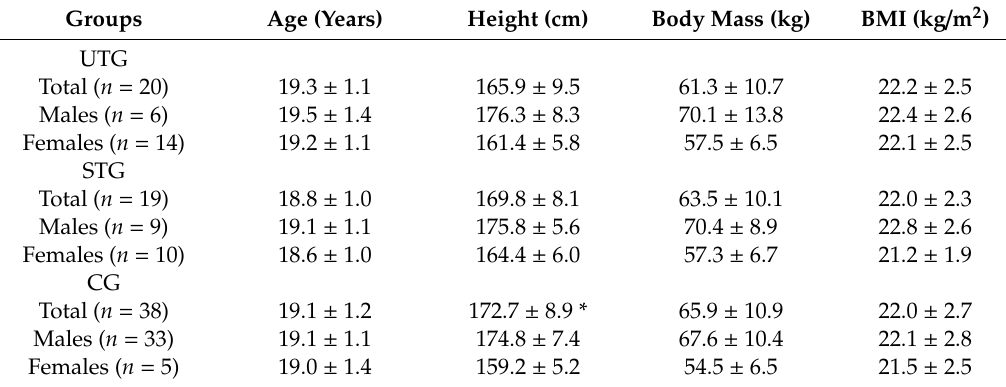
Table 1. Baseline anthropometric characteristics of the population studied, separated by group (mean ±